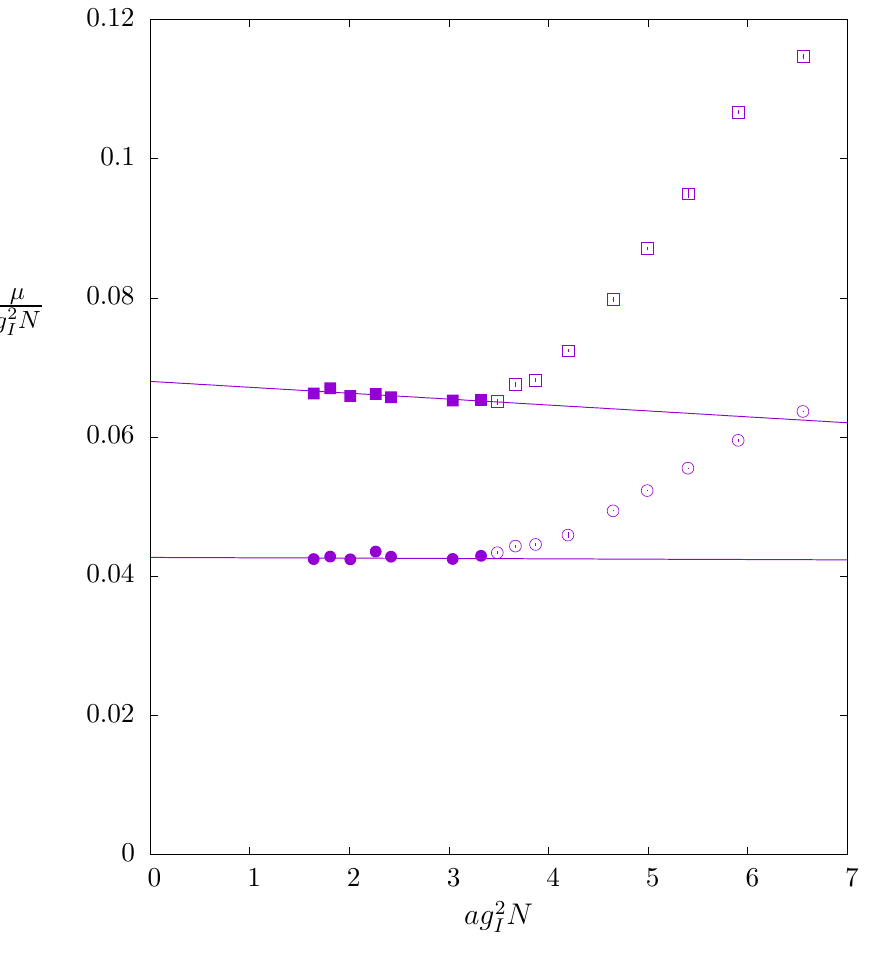
p (cid:27)=g 2 N ( (cid:14) , (cid:15) ), and lightest scalar glueball, 0 : 5 (cid:2) M I